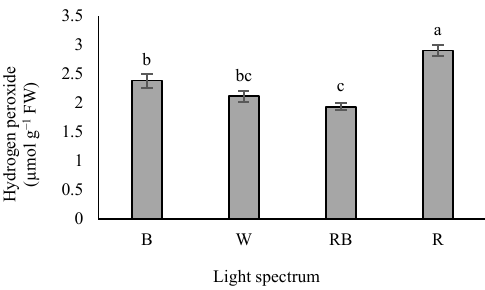
Figure 8. Hydrogen peroxide (H 2 O 2 ) level in grafted tomato seedlings exposed to different light qualities (including white (W; 35% B, 49% intermediate spectra, 16% R) light as control, blue (B), red (R), and a combination of red (68%) and blue (RB), (see the correspondence spectrum in Figure 1)), with 75 ± 5 µ mol m − 2 s − 1 PPFD for 20 days. Columns with the same letters are not significantly different at p ≤ 0.05, according to Duncan’s multiple range tests. Bars represent the mean value of three replications ± SEM.